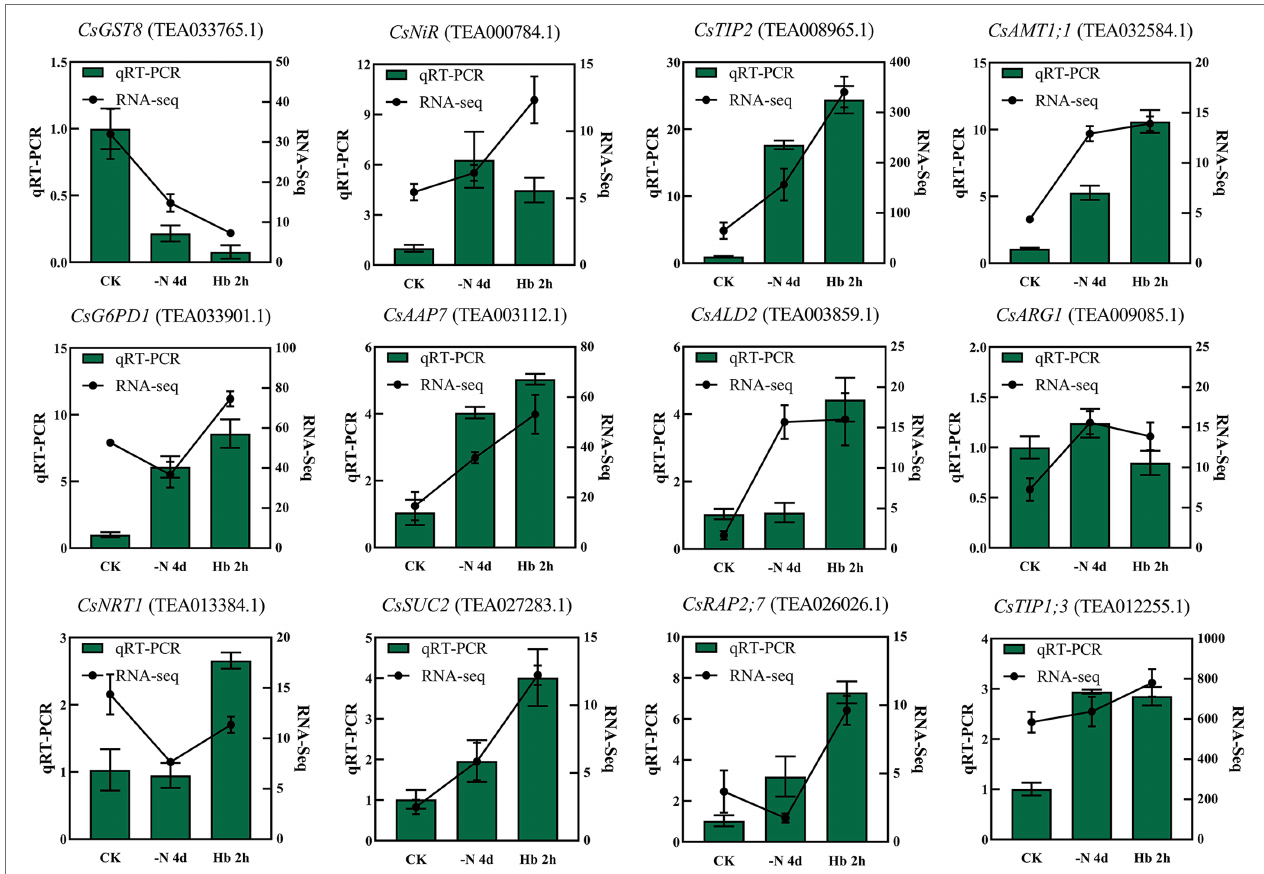
FIGURE 2 | qRT-PCR validation of the expression levels of the 12 randomly selected genes, with the expression level set to 1.0 for each gene in the CK